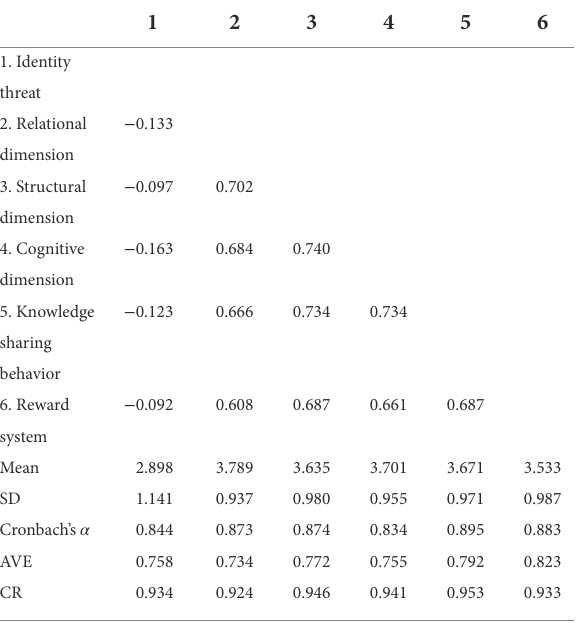
TABLE 1 Scale measurement.